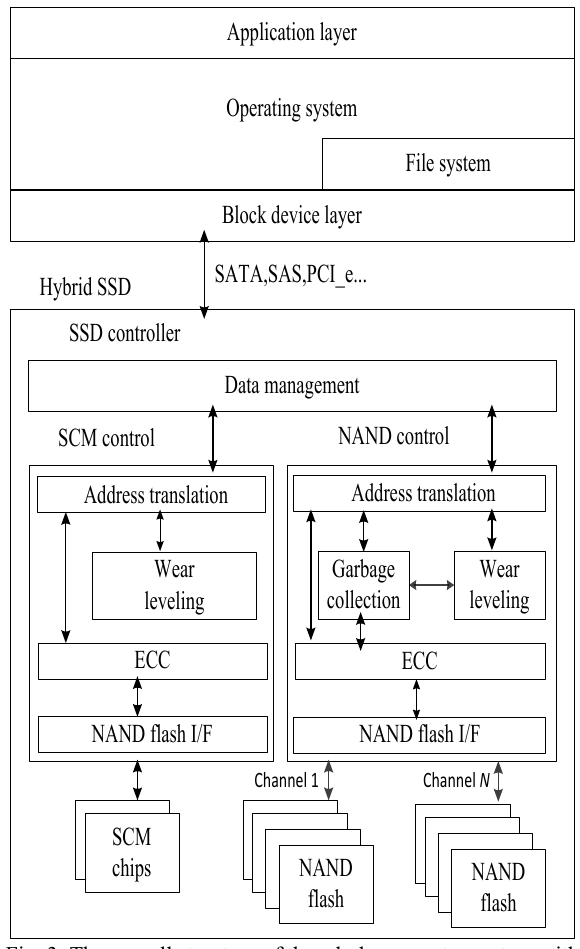
Fig. 3. The overall structure of the whole computer system with